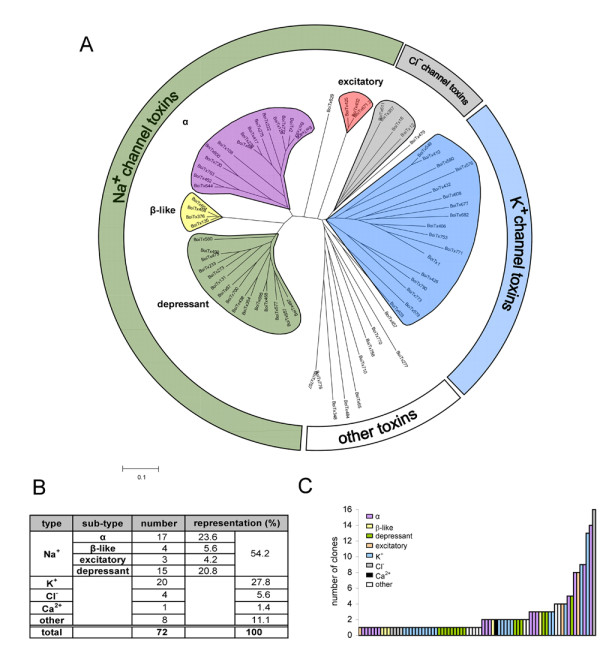
B. occitanus israelis venom gland transcript distribution. (A) A phylogenetic tree analysis of putative toxins. Toxin families are highlighted according to their estimated blocking targets, i.e. Na+, K+, Cl- or Ca2+ channels, based on homology to known toxins [16]. Putative toxins with no known homologs were termed 'other toxins'. Only full-length distinct cDNA sequences were used for the protein data set construction. (B) Toxin families' transcript distribution. The number of distinct members of each family is presented as is their relative representation within the cDNA library. (C) Transcript expression levels. The number of clones obtained for each of the individual transcripts in the cDNA library is indicated. The estimated affiliation of each transcript is shown by shading of the bars.